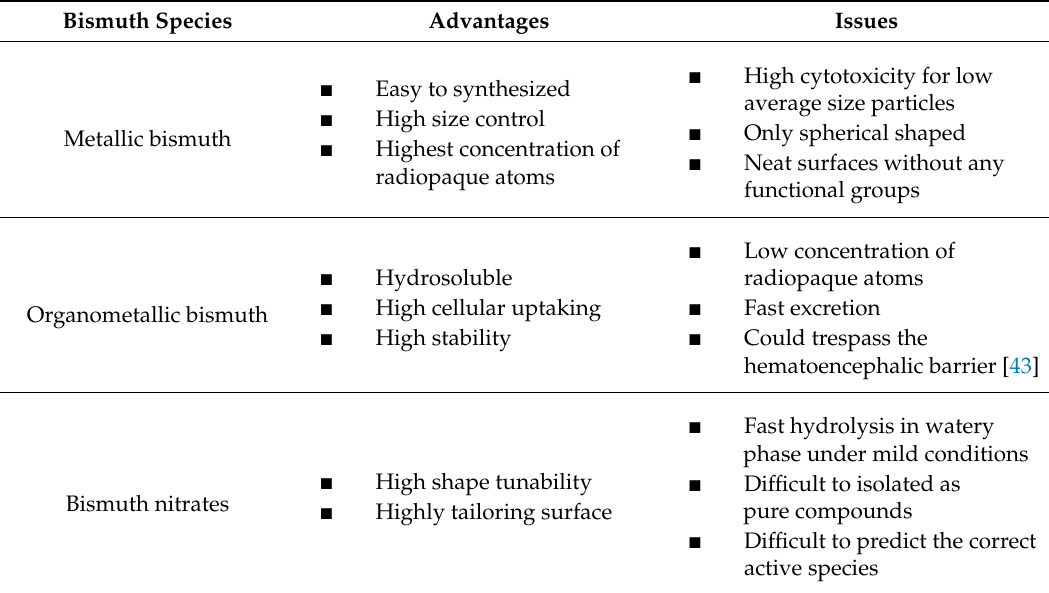
Table 1. Summary of main properties of bismuth and related